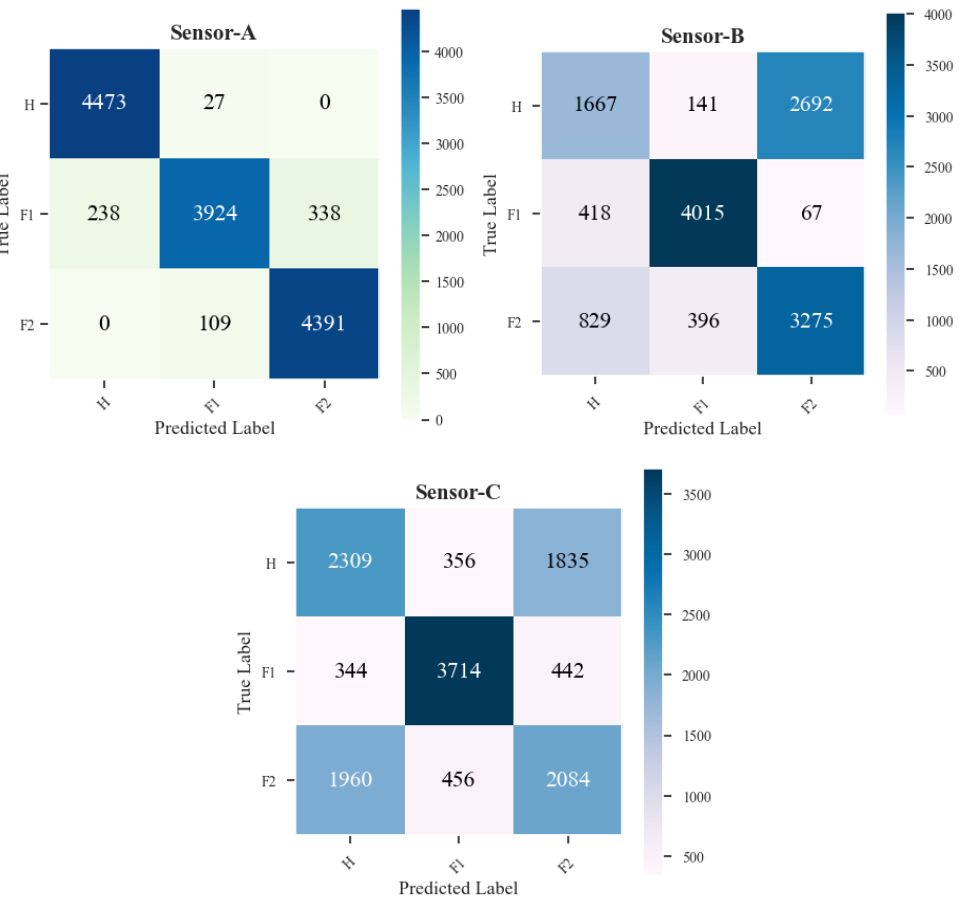
Figure 12. Confusion matrix for different sensors. Table 5. Performance evaluation of different sensor data.